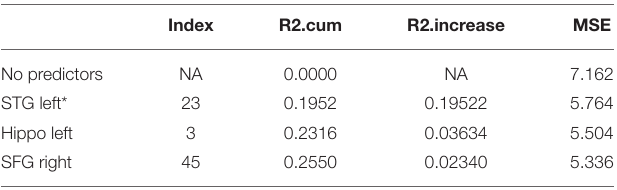
TABLE 2 | Results from a stepwise regression with the brain areas as predictors, and Trial 1 as the dependent variable.